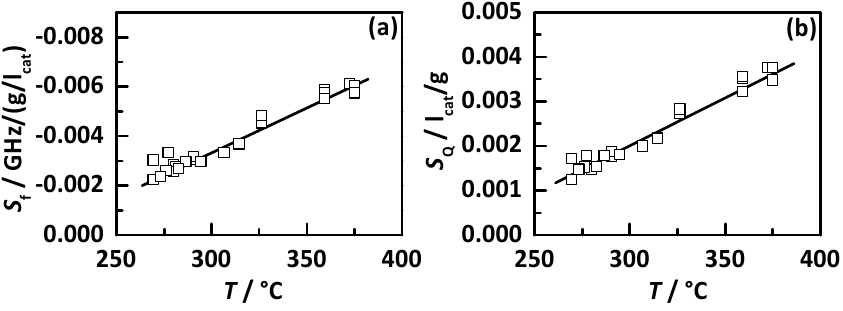
Figure 8. Sensitivity of the RF signals to NH 3 storage with ( a ) S f of the resonance frequency f res and ( b ) S Q of the reciprocal quality factor Q 0 − 1 as a function of catalyst temperature.